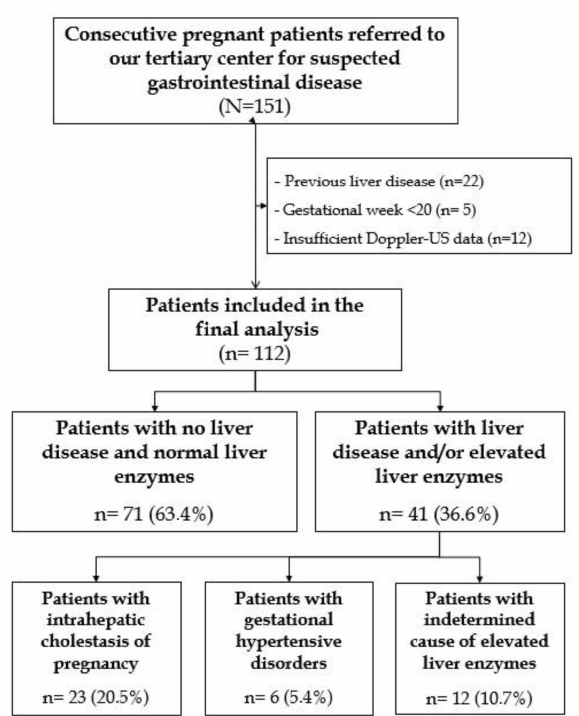
Figure 1. Flowchart of patients’ selection in our